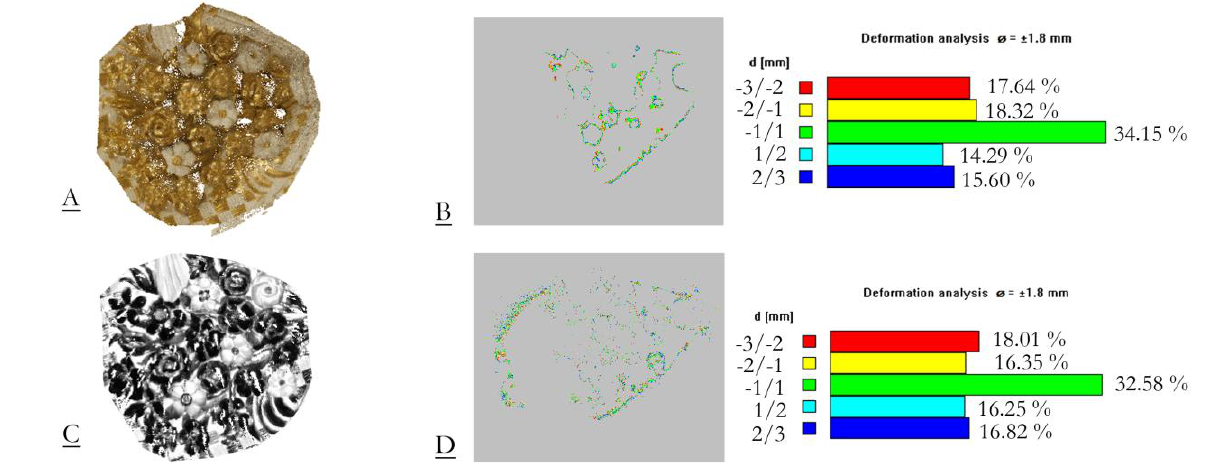
Fig. 10 Orthimage of analyzed detail. A- from image matching, C - from terrestrial laser scanning. Deviations of points from reference planes. B - the point cloud from image matching, D - the point cloud from terrestrial laser scanning. The null deviations are marked in